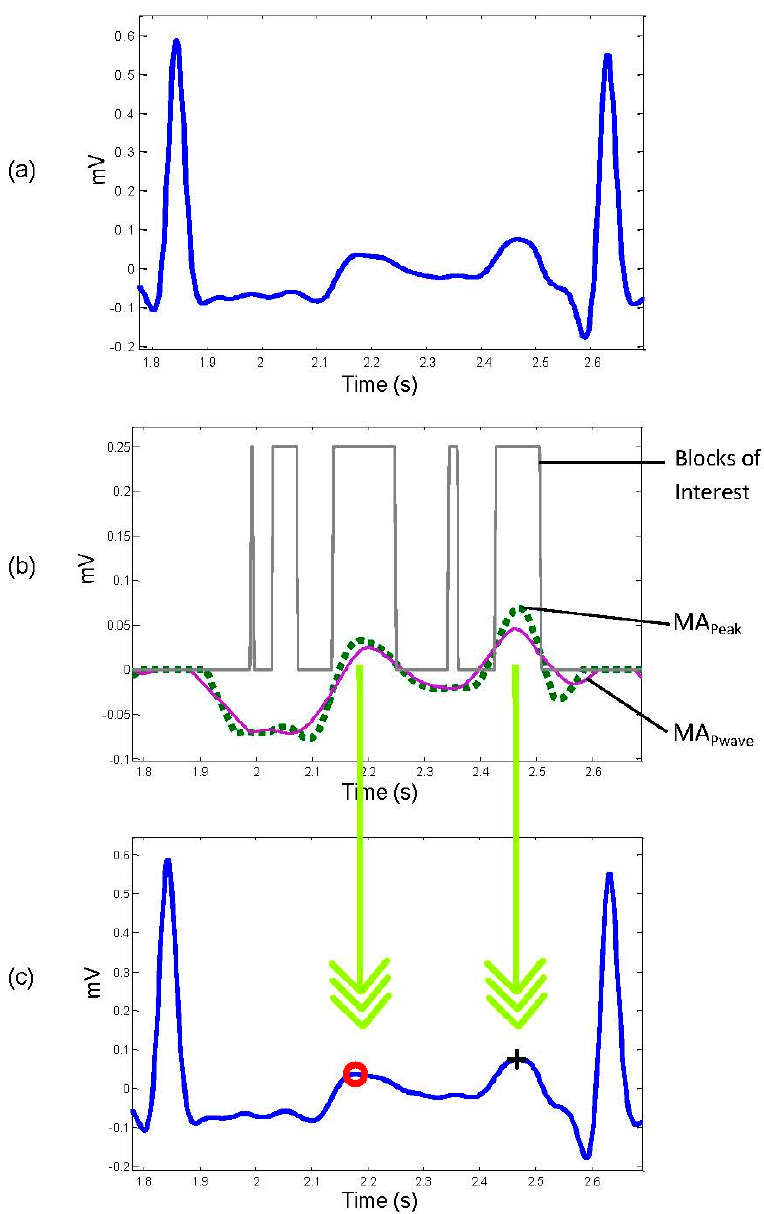
Figure 3. Application of two moving averages to detect P and T waves. ( a ) Filtered RR ECG signal with Butterworth bandpass filter; ( b ) generating blocks of interest after using two moving averages: the dotted line is the first moving average and the solid line is the second moving average; ( c ) the detected P and T waves after applying the thresholds. The red “o” identifies the T wave, while the black “+” symbol identifies the P wave.